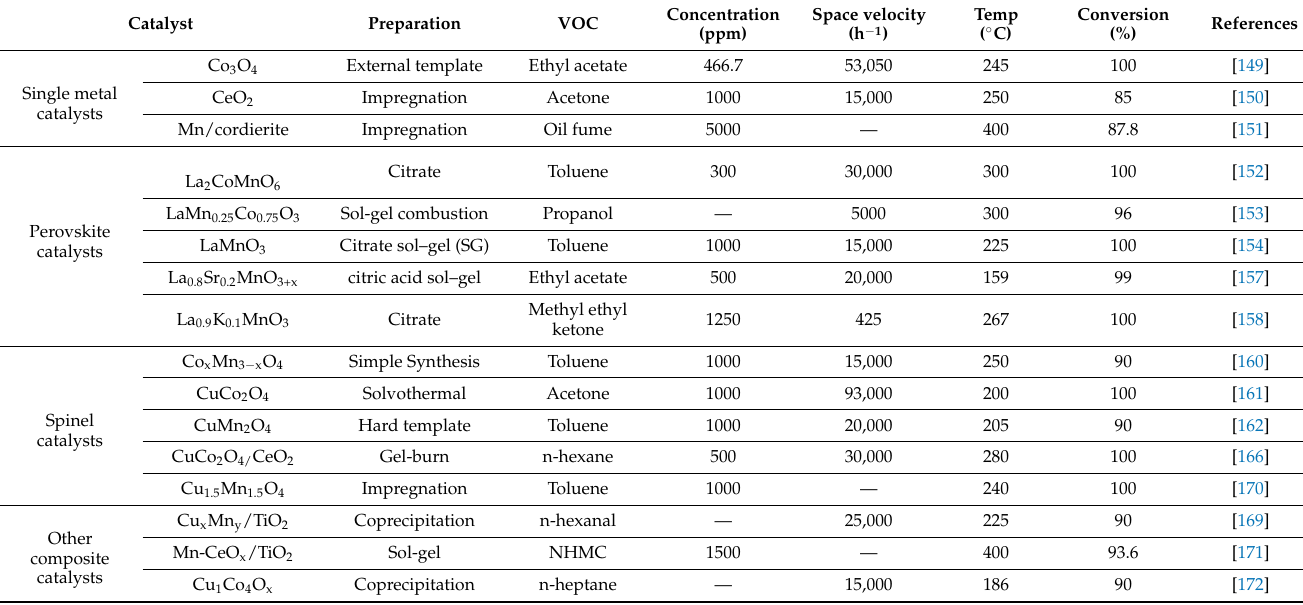
Table 6. Non-noble metal oxide catalysts for catalytic oxidation of